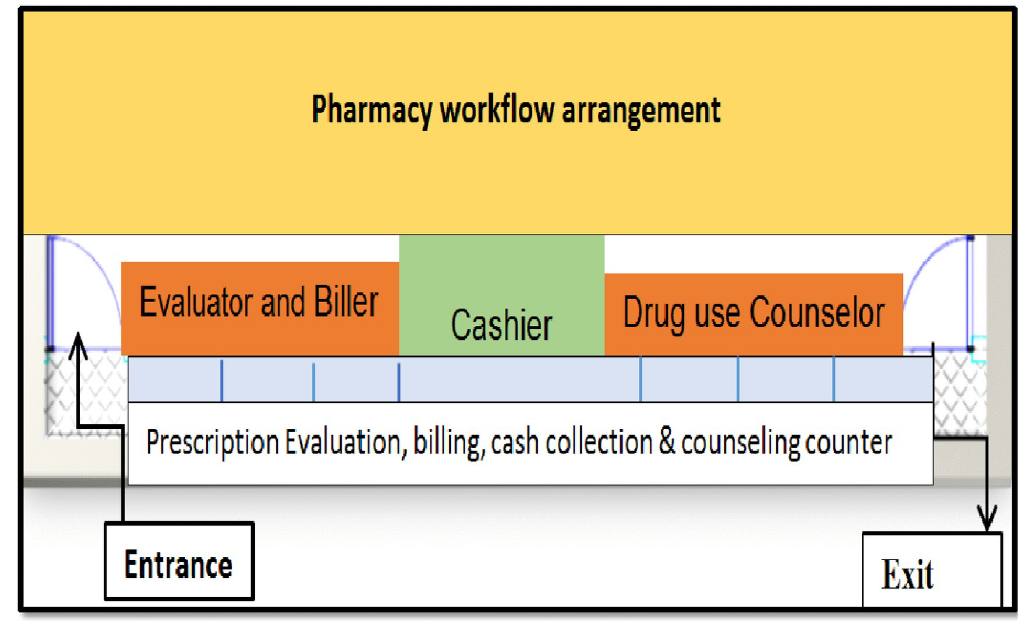
Fig 1. APTS pharmacy workflow arrangement (Source: APTS training guideline,